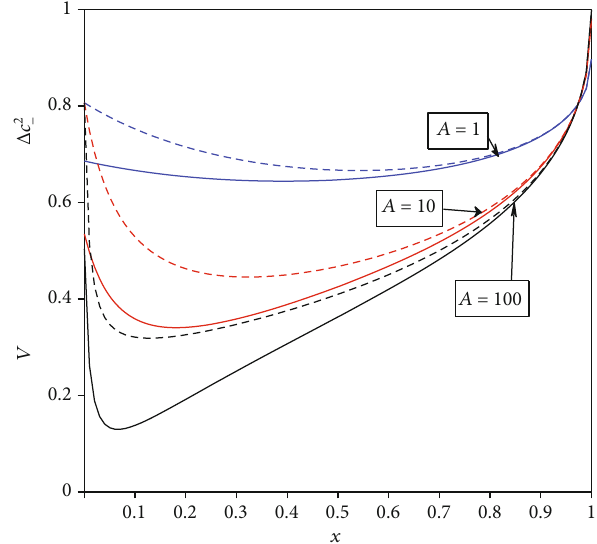
Figure 11: The minus quadrature variance Δ c 2 − (dashed curves) and the smallest eigenvalue V (solid curves) of the two-mode cavity radiation versus x for κ = 0 : 5 , ε = 0 : 06 , and di ff erent values of A